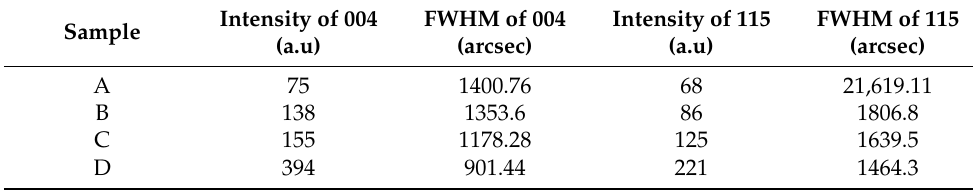
Figure 5. (004) and (115) omega-2theta HR-XRD scan curves for all Samples. Table 1. Intensity and FWHM of (004) and (115) Bragg peaks for all